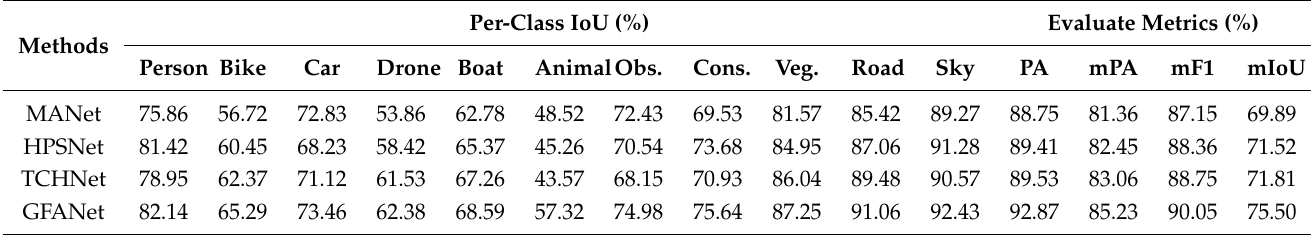
Table 5. Comparison of evaluation metrics on the clean example test set in the AeroScapes